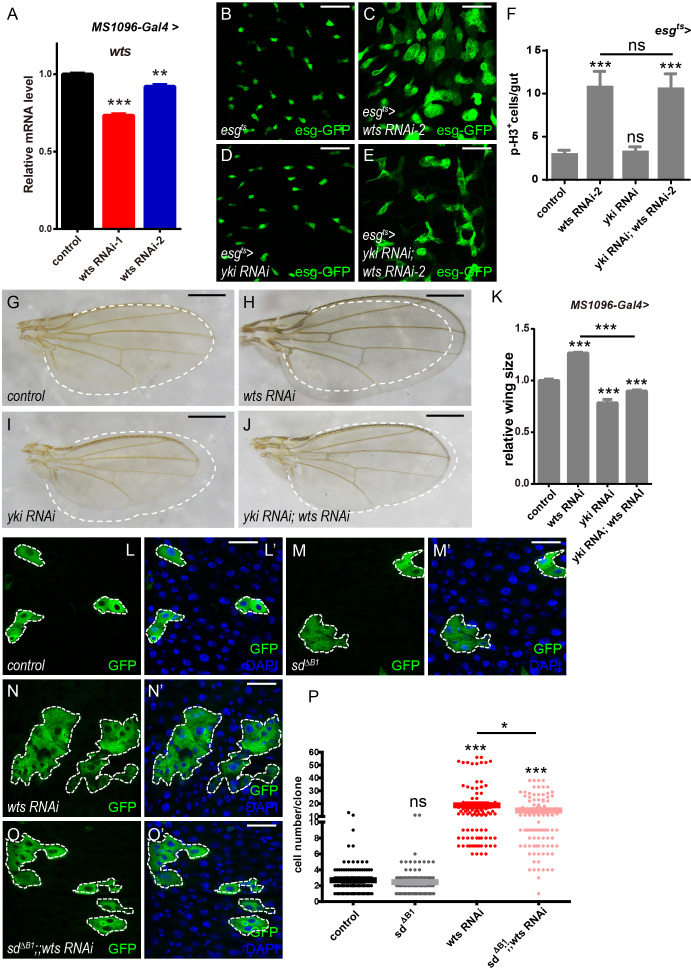
Yki is dispensable for Wts-mediated ISC proliferation in Drosophila midgut (A)Relative wts mRNA levels were analyzed by real-time PCR.Total RNAs were collected from wing discs of MS1096-Gal4 (black bar), MS1096-Gal4 > wts RNAi-1 (red bar), and MS1096-Gal4 > wts RNAi-2 (blue bar). Note a significant decrease in the mRNA levels when wts RNAi is expressed (**p<0.01 and ***p<0.001). (B-E) Representative images of Drosophila adult midguts of esg-Gal4; tubGal80ts (esgts) (B), esgts >wts RNAi-2 (C), esgts >yki RNAi (D), and esgts >yki RNAi; wts RNAi-2 (E). ISCs and EBs are marked with esg-GFP (green). (F) Quantifications of the p-H3+ cell number in adult midguts from the indicated genotypes in B-E (n = 14, 13, 14, 12). Note a significant increase in the p-H3+ cell number when wts RNAi-2 is expressed (*p<0.05). (G-J) Representative images of female wings from flies of control (G), MS1096-Gal4 > wts RNAi (H), MS1096-Gal4 > yki RNAi (I), and MS1096-Gal4 > yki RNAi; wts RNAi (J). Control wing size is marked by a white dashed line for comparison (G-J). (K) Quantifications of relative wing sizes (normalized to the control wing size) from flies with the indicated genotypes in G-J (n = 16, 22, 10, 11). Wing sizes were quantified using ImageJ software by measuring the area of wings. Note a significant increase in the wing size when wts RNAi is expressed (***p<0.001). Co-expression of yki and wts RNAi rescues the increase (***p<0.001). (L-O’) Representative images of adult midguts containing GFP positive MARCM clones of control (L-L’), sd∆B1 (M-M’), wts RNAi (N-N’), and sd∆B1 in the presence of wts RNAi (O-O’). Midguts were dissected 4 days after clone induction and immunostained with DAPI (blue). Areas enclosed by the dashed lines indicate respective clone size. Merged images are shown in L’, M’, N’, and O’ (green and blue). (P) Quantifications of the cell number per clone in adult midguts from the indicated genotypes in L-O. Note that sd∆B1 partially suppresses the large clone size induced by wts RNAi (*p<0.05). Average 90–110 clones from 10 midguts were quantified for each genotype. Scale bars: 30 μm in B-E, L’-O’; 500 μm in G-J. Data are shown as mean ± SEM. P-values of significance (indicated with asterisks, ns no significance p>0.05, *p<0.05, **p<0.01, and ***p<0.001) are calculated by Student’s T-test. At least 10 midguts or female wings were dissected for each genotype. Confocal images were taken from the basal layer of the midgut where ISCs can be clearly visualized. Single layer image is shown.